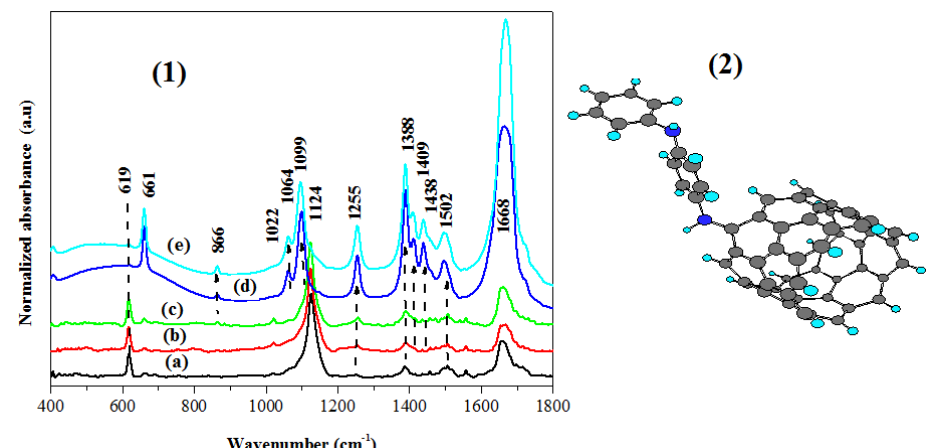
Figure 13. ( 1 ) FTIR spectra of PANI/SWCNT nanocomposites with various SWCNT concentrations: ( a ) 0%, ( b ) 0.71%, ( c ) 1.16%, ( d ) 2.10%, and ( e ) 5.00%. ( 2 ) Model structure of the nanocomposite used for DFT calculation [19].